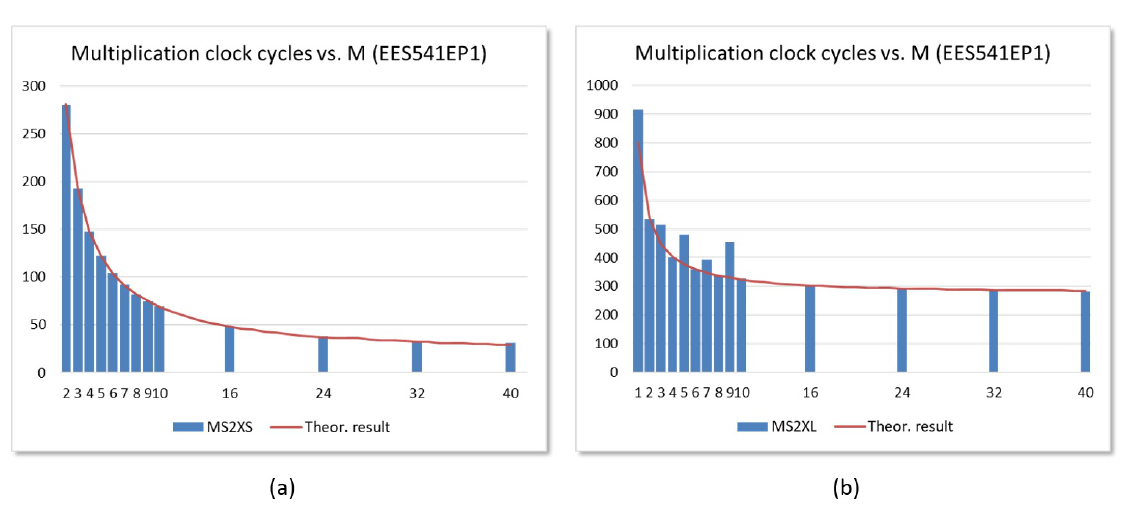
Figure 17. Clock cycles required to complete polynomial multiplication for embedded systems that incorporate IPs MS2XS ( a ) and MS2XL ( b ), implementing the EES541EP1 parameter set with different values of M in a Zynq-7000